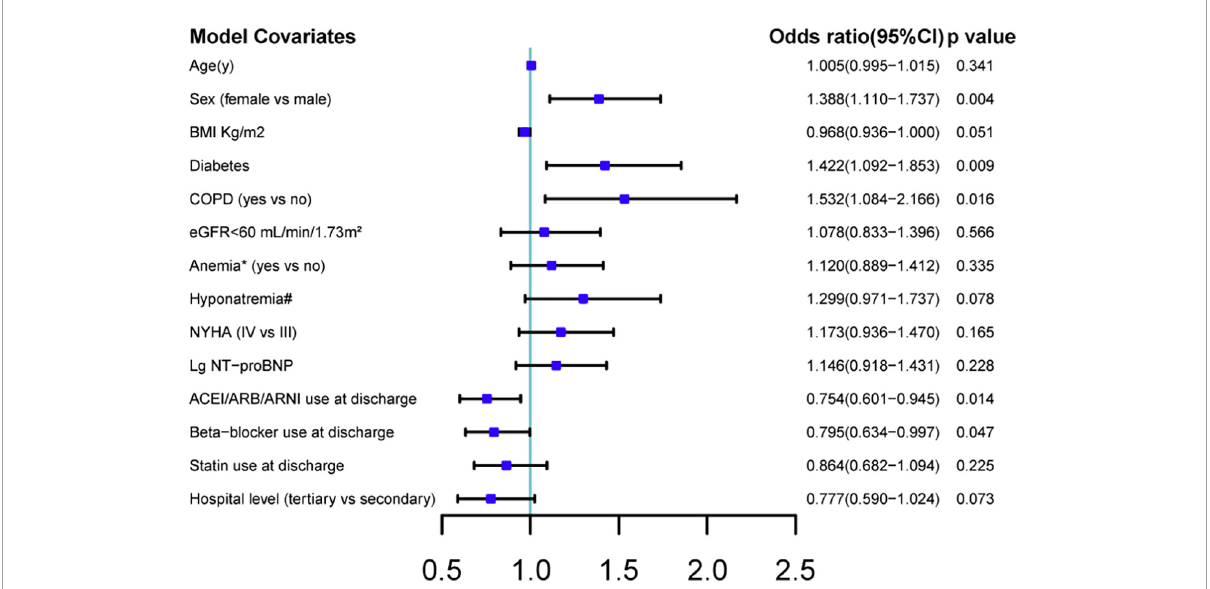
FIGURE2 Multiple logistic regression analysis of predictive factors associated with post-discharge depression. BMI, body mass index; NYHA, New York Heart Association; COPD, chronic obstructive pulmonary disease; eGFR, estimated glomerular filtration rate; ACEI, angiotensin-converting enzyme inhibitors; ARB, angiotensin receptor blockers; ARNI, angiotensin receptor-neprilysin inhibitors; Lg NT-proBNP, log-transformed values of N-terminal pro-B-type natriuretic peptide. CI: confidence interval. Factors in baseline characteristics with a p-value < 0.1 were included. Anemia, hemoglobin < 13 g/dl in male patient or hemoglobin < 12 g/dl in female patient. Hyponatremia, serum sodium concentration < 135 mmol/L.